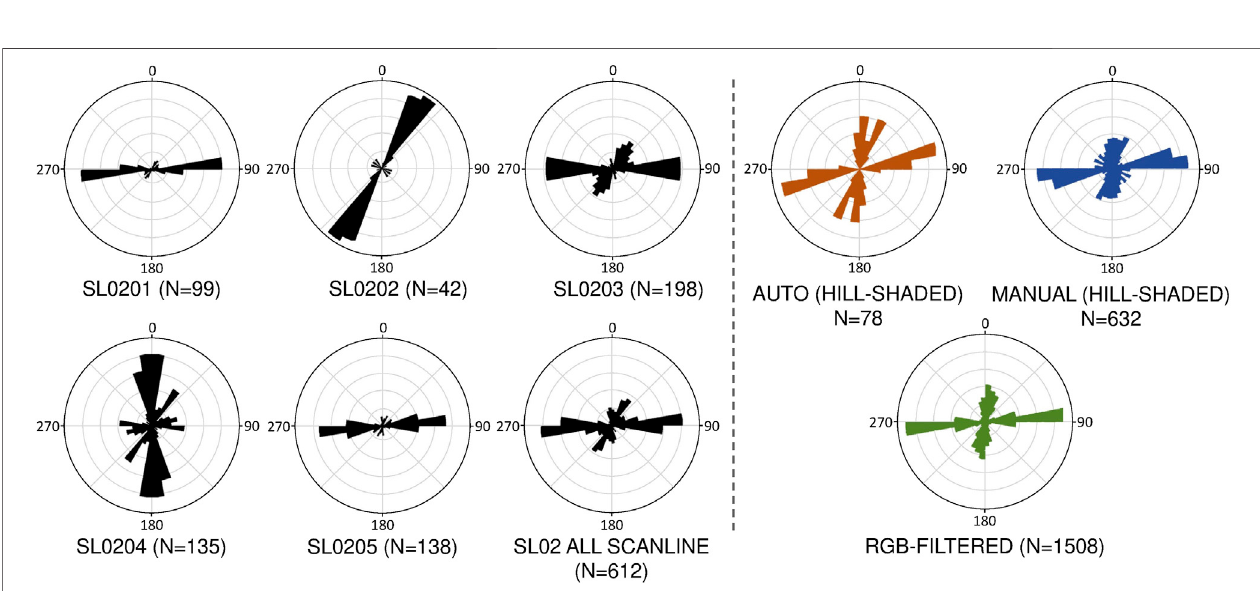
FIGURE7| Plotsofthelineamenttrendsobtainedfromscanline(blackgraphs),automatedhill-shade(orangegraphs),manualhill-shaded(bluegraphs),andRGB- fi ltered DSM (green graphs) are portrayed on rose diagrams.